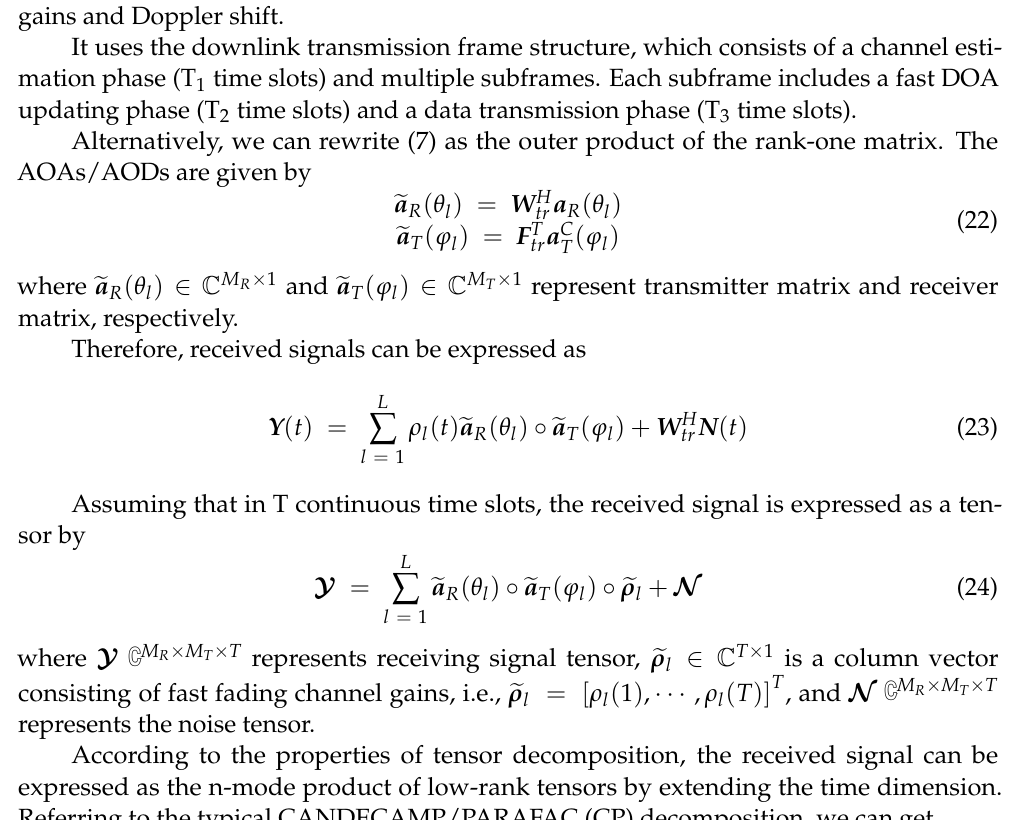
Figure 1. Adopted dynamic hybrid precoding structure.